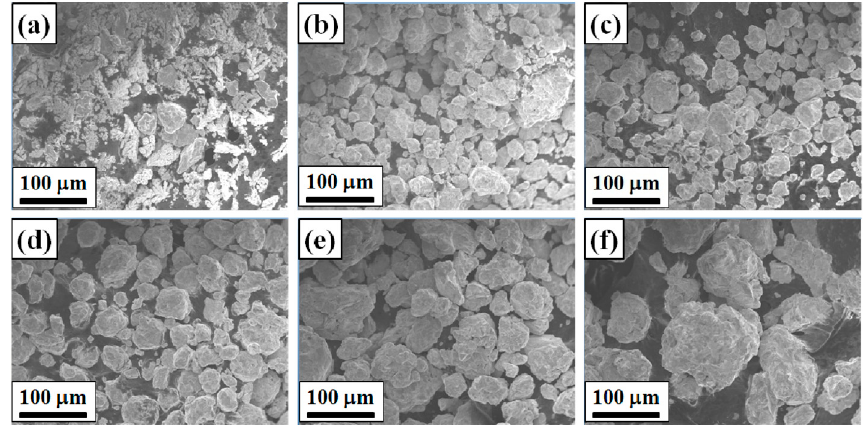
Figure 4. SEM photos of Ni 0 HEAP after different ball milling times: ( a ) 0 h, ( b ) 5 h, ( c ) 10 h, ( d ) 15 h, ( e ) 30 h, ( f ) 45 h. ( e ) 30 h, ( f ) 45